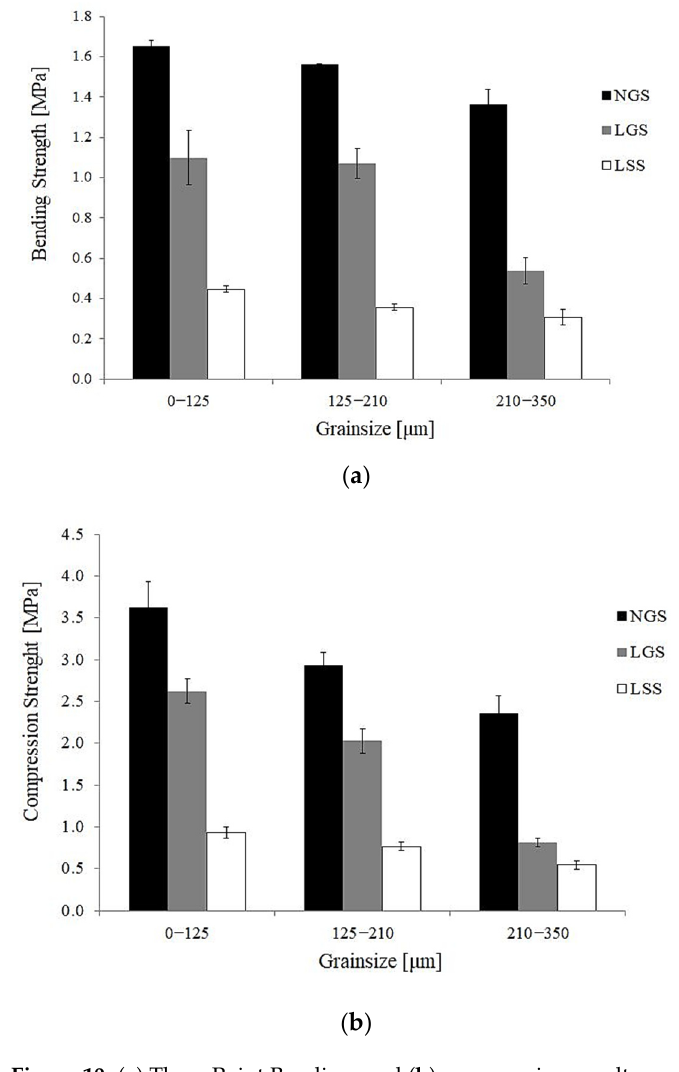
Figure 10. ( a ) Three Point Bending, and ( b ) compression results.